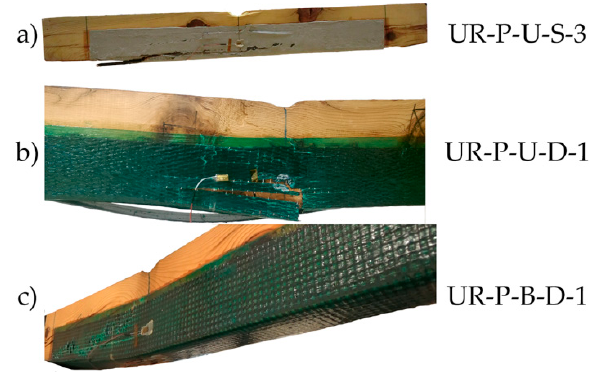
Figure 19. Breakage images of the UR-P beams group: ( a ) UR-P-U-S-3; ( b ) UR-P-U-D-1; and ( c ) UR-P-B-D-1. CFRP supplier: SIKA ® and DRIZORO ® .